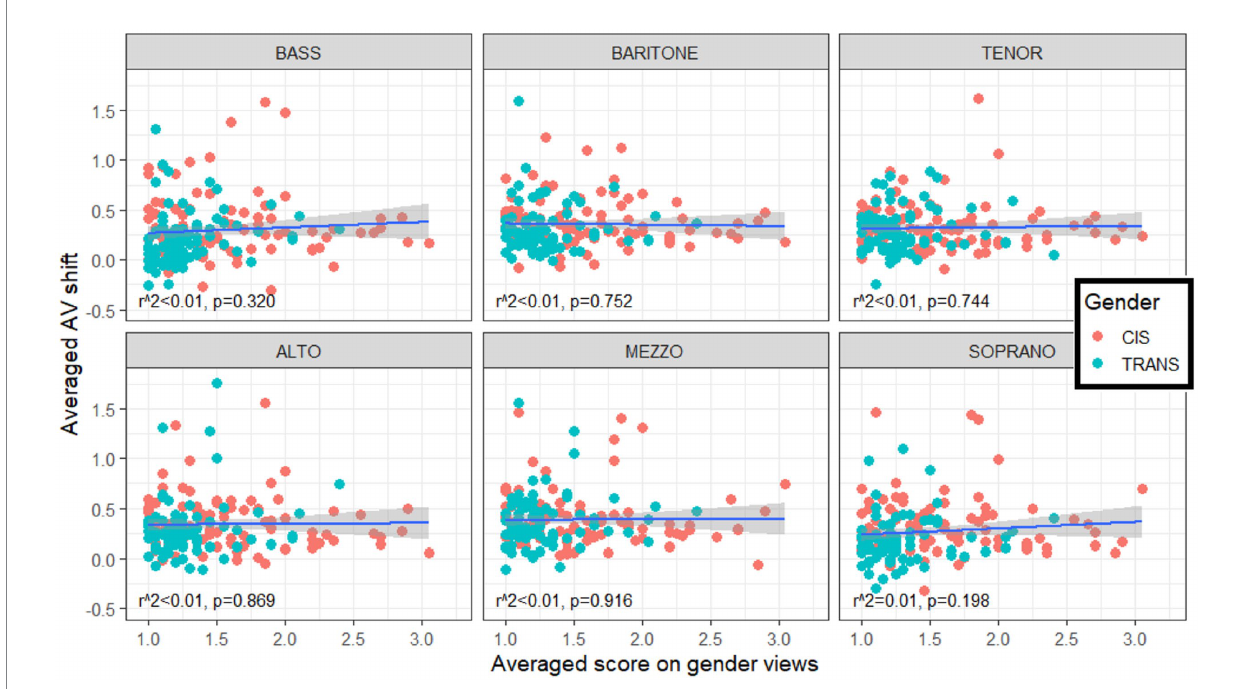
FIGURE 6 Lack of correlation between individuals’ average score on gender views (abscissa) and their average AV shift (signed, so that positive values indicate a shift in the direction of the visual bias). The degree to which a given participant was biased in their appreciation of vocal range by the visual cues taken from the actors’ face/body size and shape was not related to their views of gender roles in society.